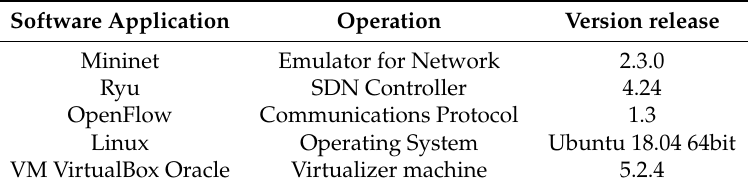
Table 5. Experimental and evaluation